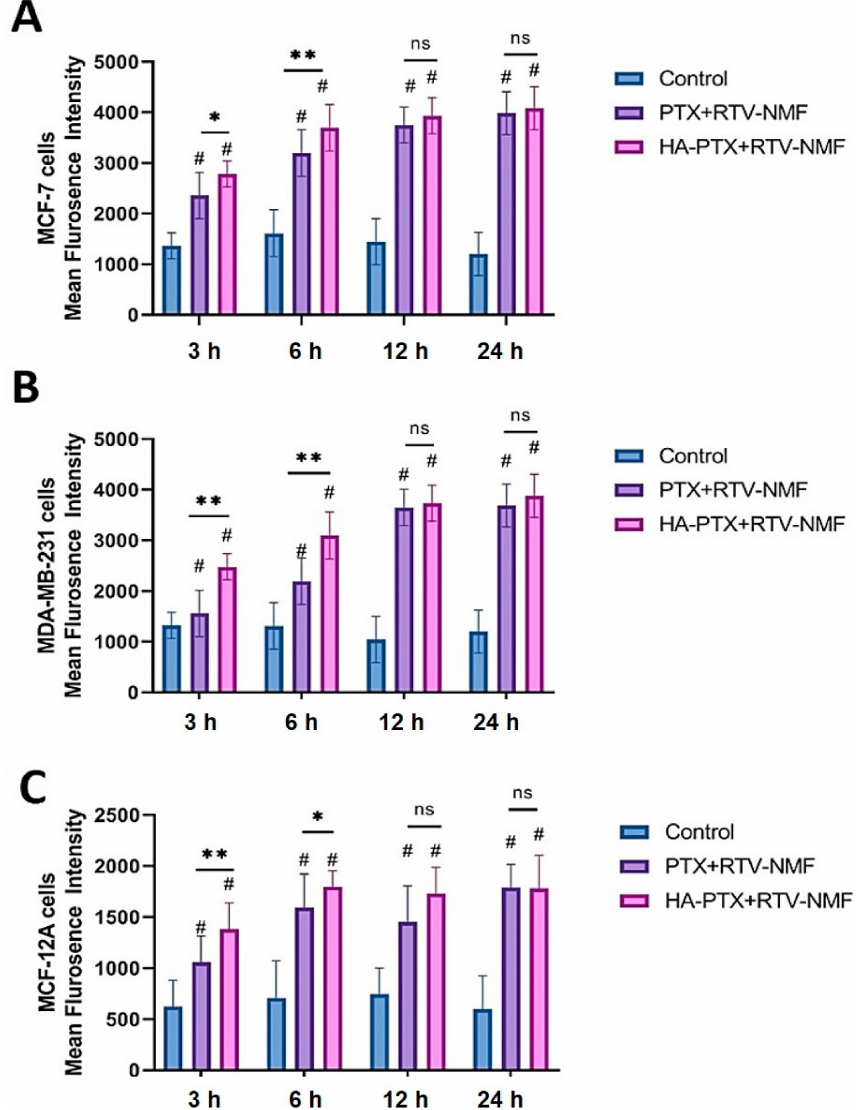
Figure 8. Time-dependent uptake of FITC-labeled HA − PTX + RTV − NMF solution and FITC- labeled PTX + RTV − NMF solution in breast cancer MCF-7 and triple-negative breast cancer, MDA-MB-231 cells. ( A ) Uptake of FITC-labeled HA − PTX + RTV − NMF solution and FITC-labeled PTX + RTV − NMF solution at 3, 6, 12, and 24 h in MCF-7 cells, ( B ) uptake of FITC-labeled HA − PTX + RTV − NMF solution and FITC-labeled PTX + RTV − NMF solution at 3, 6, 12, and 24 h in MDA-MB-231 cells. ( C ) Uptake of FITC-labeled HA − PTX + RTV − NMF solution and FITC-labeled PTX + RTV − NMF solution at 3, 6, 12, and 24 h in MCF-12A cells. The data were expressed as mean ± SD ( n = 3). (# = significant difference as compared to control group and * p ≤ 0.05, ** p ≤